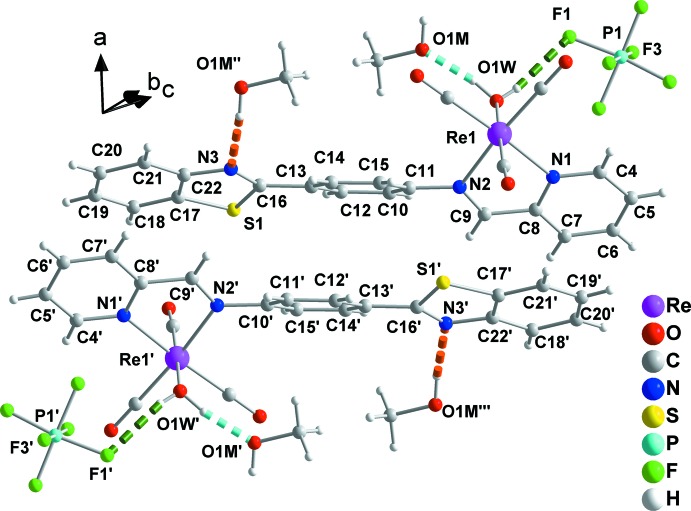
Dimers of complexes formed through π–π overlap between their coordinating NNbz ligands and inter­molecular inter­actions between dimers with methanol solvent mol­ecules and PF6
− counter-anions. Colour code as in Fig. 1 ▸ with the additional O1M—H201⋯N3 inter­actions indicated by orange dashed lines. [Symmetry codes: (′) 1 − x, 1 − y, 1 − z; (′′) 2 − x, 1 − y, 1 − z; (′′′) −1 + x, y, z.]